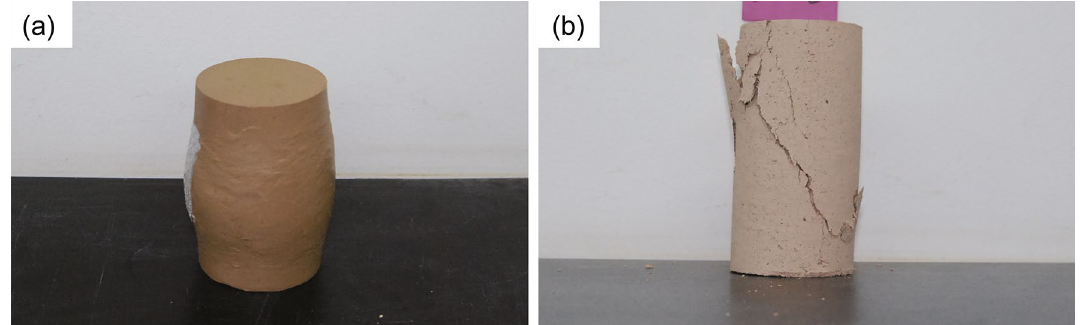
Figure 7. Photographs of ( a ) S-2a and ( b ) S-11d after unconfined compression tests. S-2a was deformed plastically, without any failure plane, whereas S-11d shows a failure mode typical of rock.